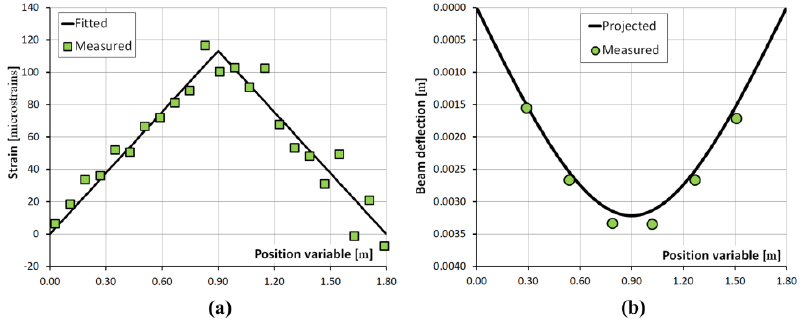
Figure 4. ( a ): B-OCDA strain measurements (squares), and computed strain after the calibration of bending stiffness (solid). ( b ): Independent point-measurements of beam deflection obtained with mechanical indicators (circles), and projected deflections based on the Brillouin analysis calibration of bending stiffness (solid) [42].